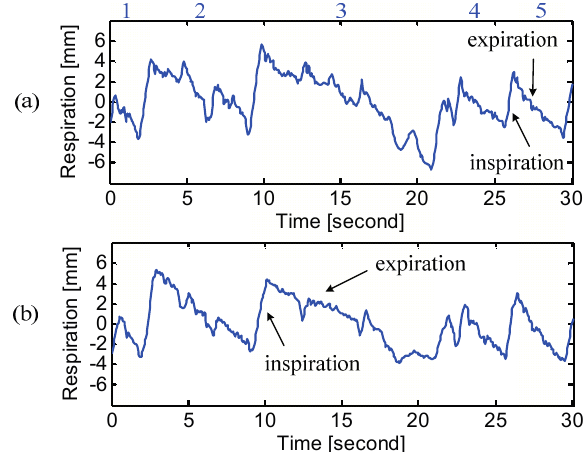
Figure 10. Radar measured respiration pattern of “speaking” overlaid with the words spoken at ( a ) chest and ( b ) abdomen. The pattern shows fast inspiration and slow expiration. The sections of words spoken are: “ 1. Oh; 2. Say can you see by the dawn’s early light; 3. What so proudly we hailed at the twilight’s last gleaming; Whose broad stripes and bright stars thru the perilous fight; 4. O’er the ramparts we watched; were so gallantly streaming; 5. And the rocket’s red...”